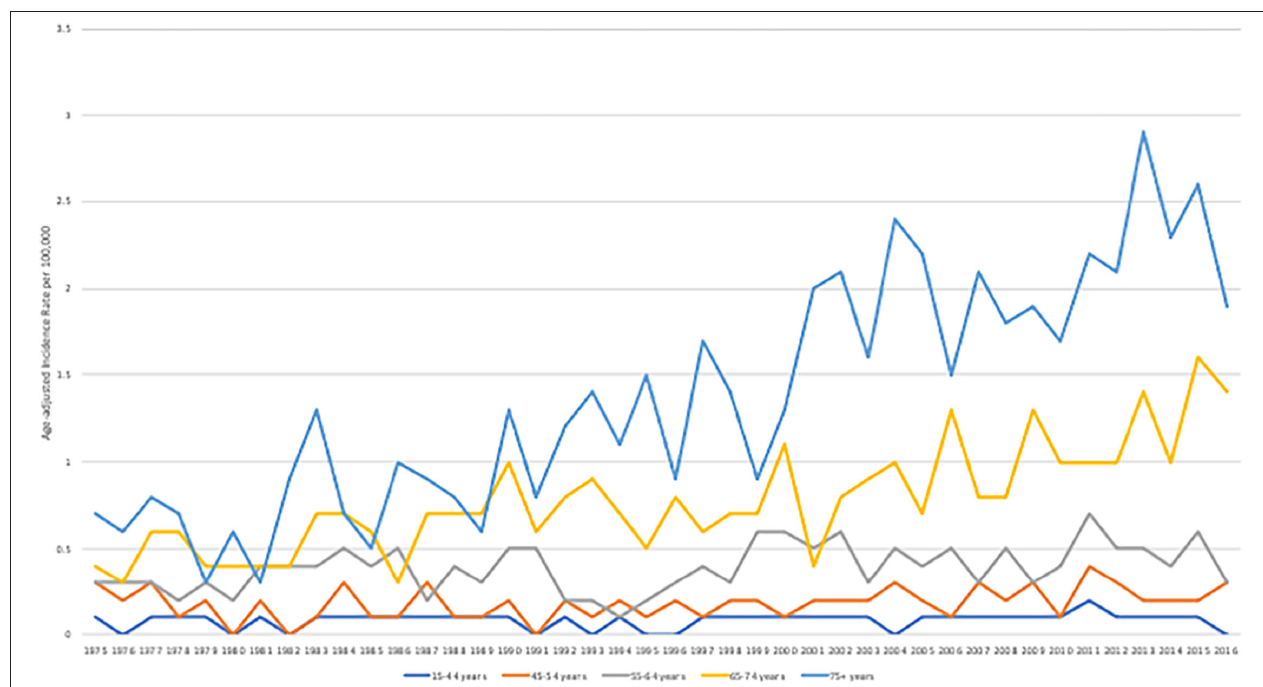
FIGURE 2 | Age-adjusted incidence rate per 100,000 stratified by age groups between 1975 and 2016. The SEER Program 9 Regs Research Data was used. All cases from 9 registries from 1975 to 2016 were